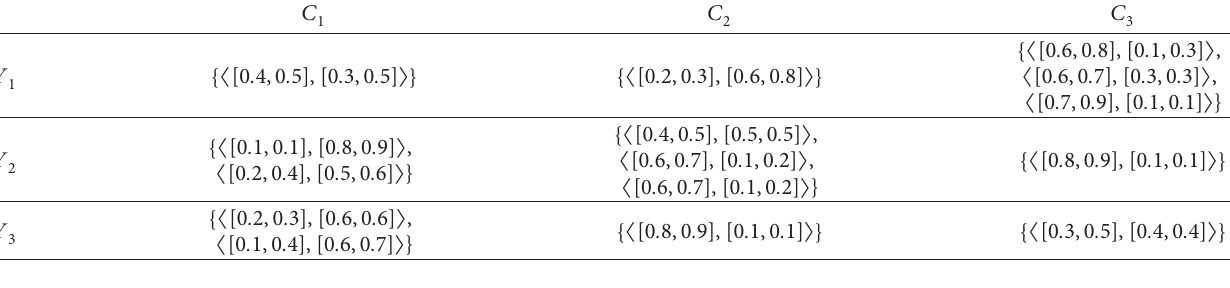
Table 2: IVPHFDM M ( 2 )